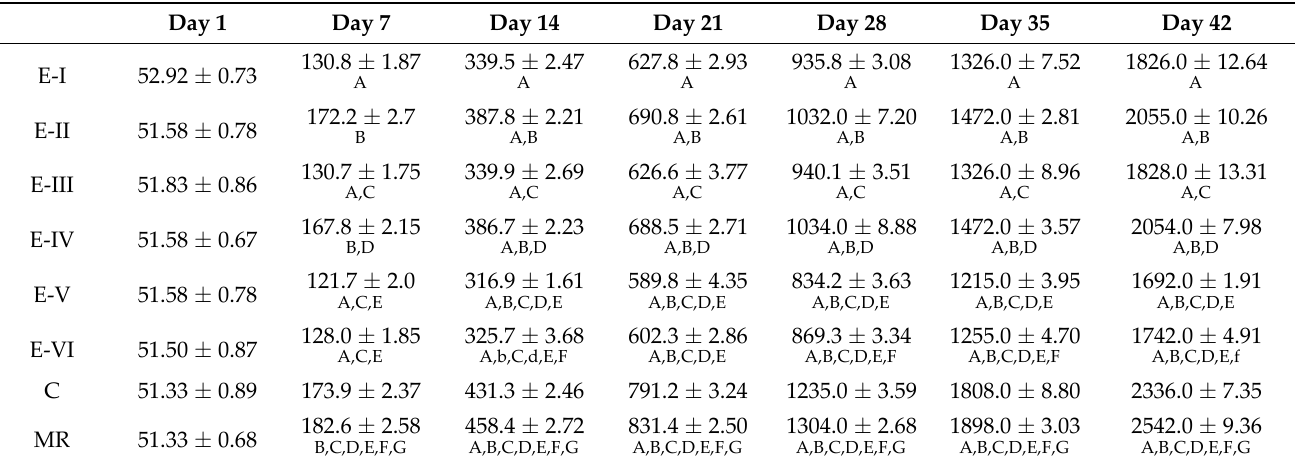
Table 2. Average body weights (g) of broilers during the study (x ± Sx).